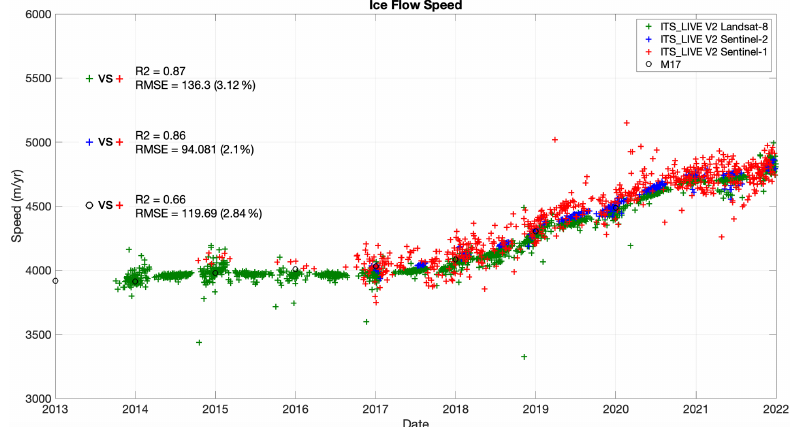
Figure 17. Time series of ITS_LIVE Sentinel-1 image-pair velocities, MEaSUREs Annual Antarctic Ice Velocity Maps (denoted as “M17”), and ITS_LIVE Version 2 Sentinel-2 and Landsat-8 products for Antarctica’s Pine Island Glacier for the location of the red cross marker (75.14 ◦ S, 100.13 ◦ W) in Fig. 15. The inter-product comparison metrics are also shown. The comparison includes 605 ITS_LIVE Sentinel-1, 1957 ITS_LIVE Version 2 Landsat 8, 223 ITS_LIVE Version 2 Sentinel-2 image-pair products as well as 16 MEaSUREs Annual Antarctic Ice Velocity Maps. The time separation between repeat images ranges from 16 to 544d for Landsat 8 and 10 to 530d for Sentinel-2